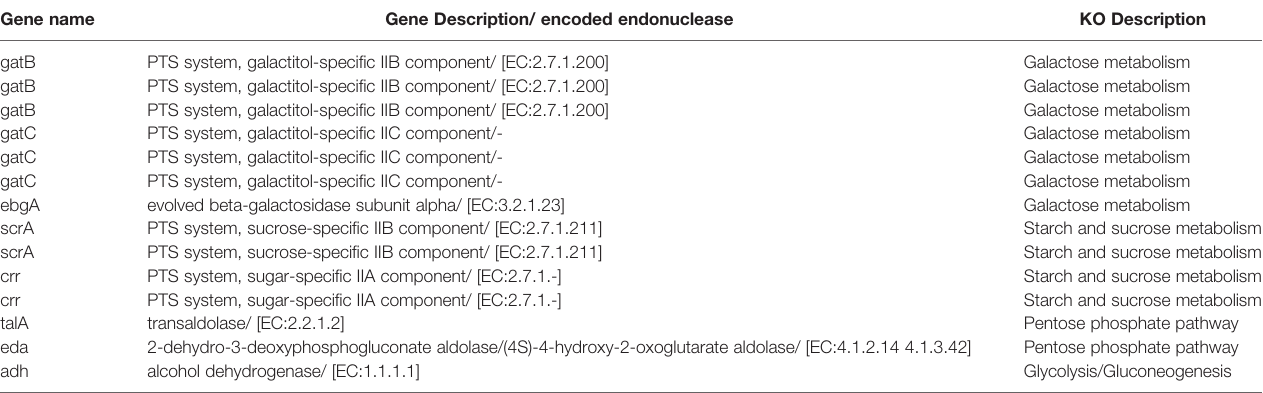
alcohol dehydrogenase/